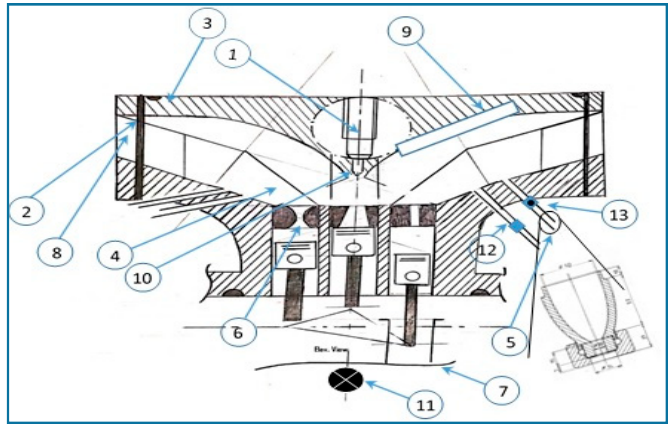
Figure 7. Prototype of rig device layout in the spraying sector.